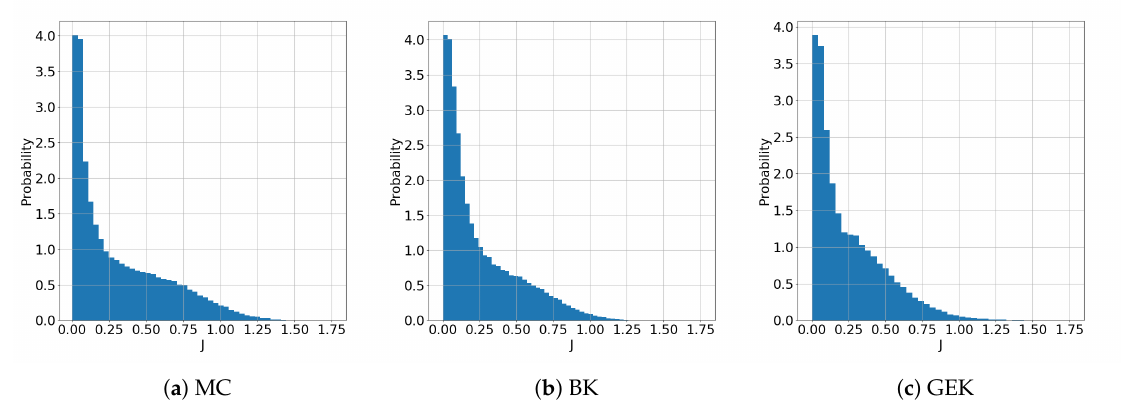
Figure 7. pdf of the QoI J for the optimal solutions in Table